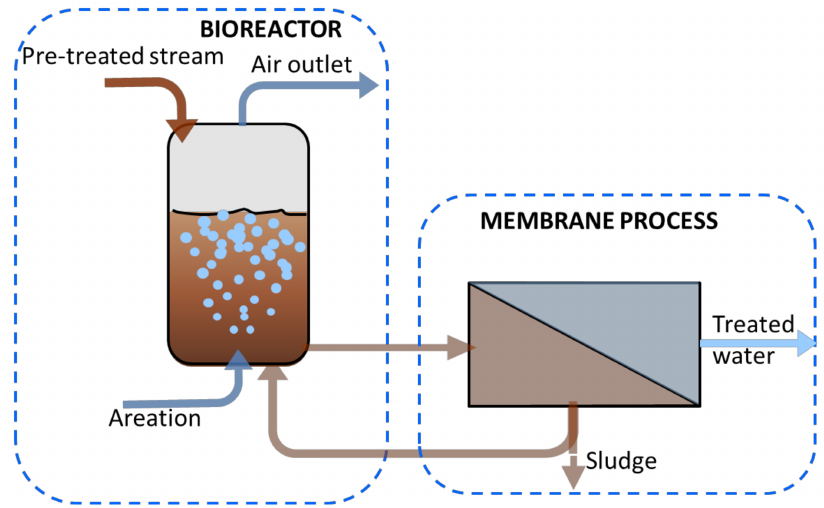
Figure 5. Schematic representation of a MBR